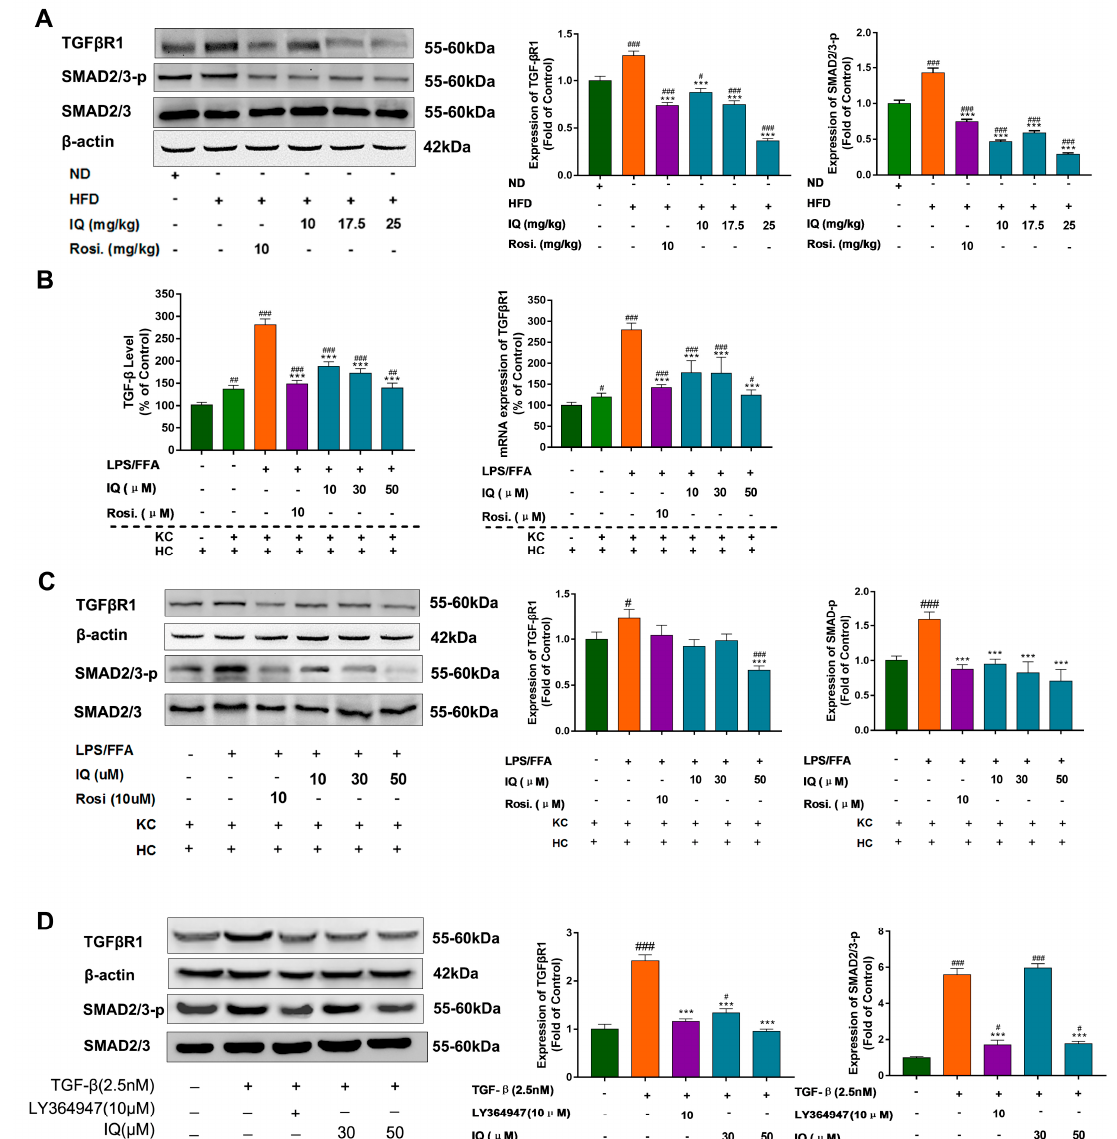
Figure 4. IQ suppresses TGF- β release, downregulate TGF- β R1 in HFD fed rats and co-culture model. ( A ) Representative blots of TGF- β R1 and SMAD2/3 in HFD group; ( B ) shows the TGF- β level in LPS/FFA induced co-culture cell by ELISA test and the mRNA expression of TGF- β R1 of LPS/FFA induced co-culture cell; ( C ) shows the representative blots of TGF- β R1 and SMAD2/3 in LPS/FFA induced co-culture model; ( D ) in vitro effects of IQ in TGF- β induced cultured cells (L02) on TGF- β R1 and SMAD2/3. # p < 0.05, ## p < 0.01, ### p < 0.001 represent compared with control. *** p < 0.001 represent compared with model. The significant statistical difference as calculated by one-way ANOVA with Tukey’s post hoc test.